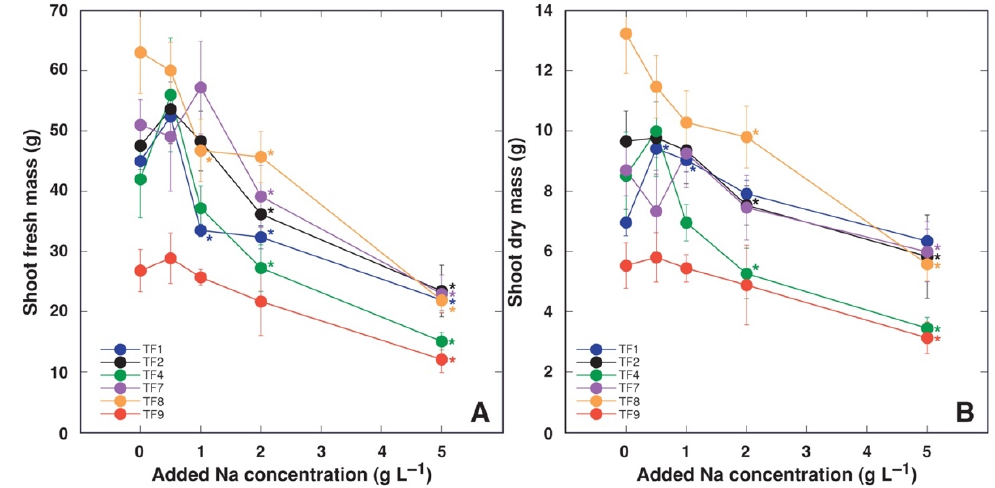
Figure 1. Effect of increasing substrate salinity on shoot fresh mass ( A ) and shoot dry mass ( B ) of Trifolium fragiferum plants of different accessions. Asterisks of respective color indicate statistically significant differences from control ( p < 0.05). Table 1. Effect of increasing substrate salinity on morphological parameters of Trifolium fragiferum plants of different accessions.